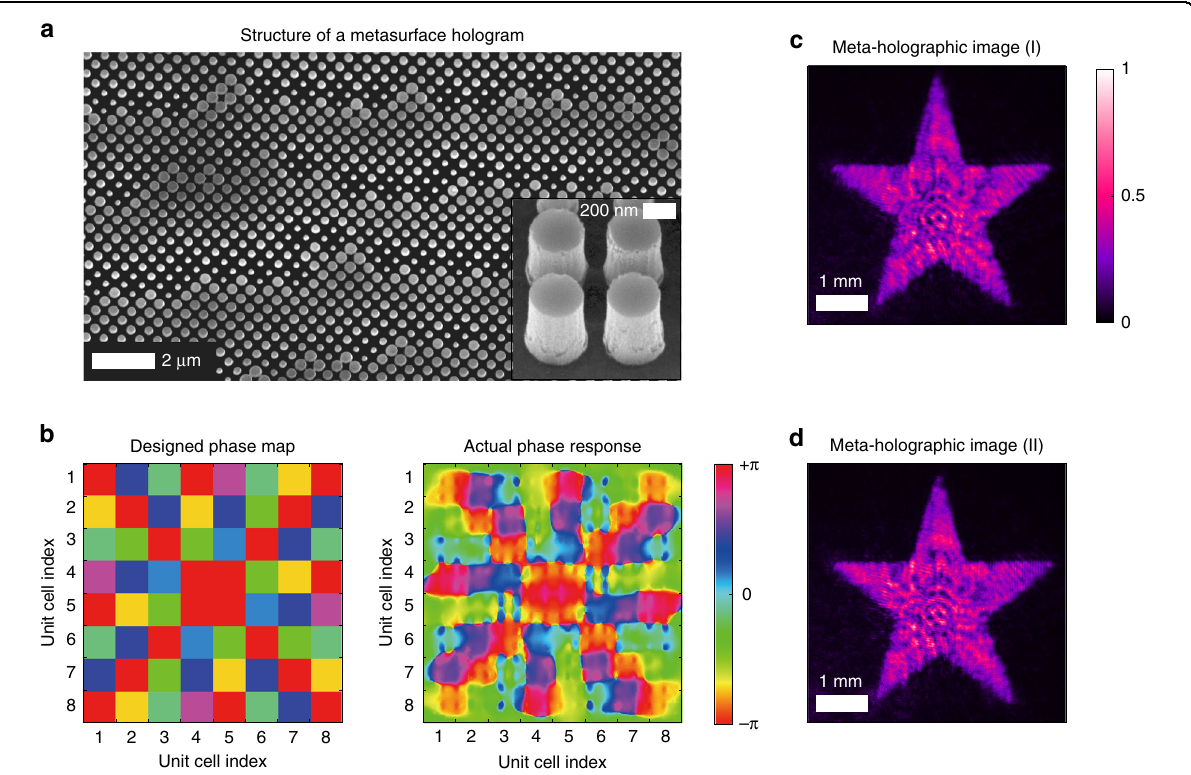
Fig. 1 Coherent artifacts of metasurface hologram. a Scanning electron microscope (SEM) image of a part of a meta-hologram comprised of 128 × 128 unit cells, each having 2 × 2 silicon nanopillars of the same diameter D . The spatial phase modulation is achieved by varying D from 142 to 366 nm. Inset: magni fi ed view of the silicon nanopillars revealing surface roughness which causes unwanted scattering and interference of light. b (left) Designed phase map φ H of a small meta-hologram comprised of 8 × 8 unit cells, based on the calculated phase response of individual nanopillars with different diameters. b (right) Actual phase response φ A from a numerical simulation of the entire metasurface, showing a signi fi cant deviation from the designed one due to near- fi eld interactions among neighboring nanopillars. c , d Holographic images of a star object generated by two fabricated meta-holograms with the same design shown in ( a ). Their intensity fl uctuations are nearly identical, indicating that the fl uctuations result mainly from deterministic interactions among meta-atoms. Optical vortices are already eliminated from the computer-generated hologram. The illumination source is a monochromatic laser at wavelength λ = 1064 nm, which has a high spatial and temporal